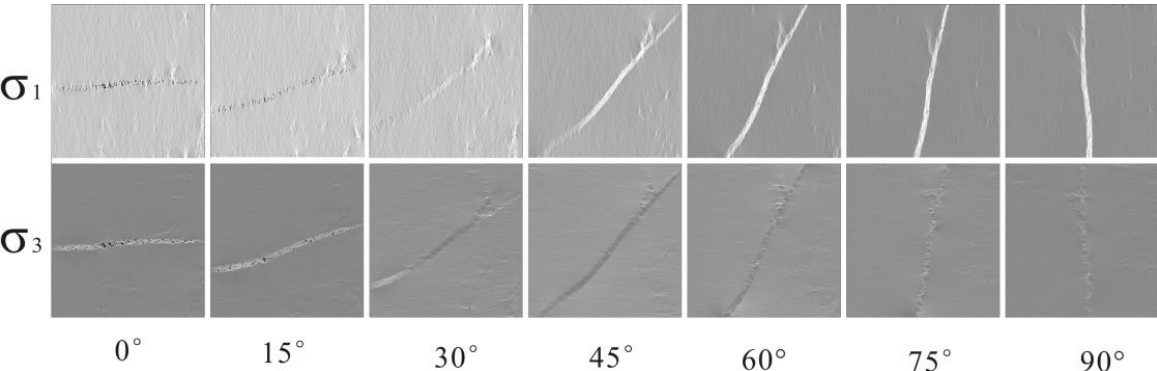
Figure 5. Stress − strain relation curves of coal and rock under diverse azimuth angles.